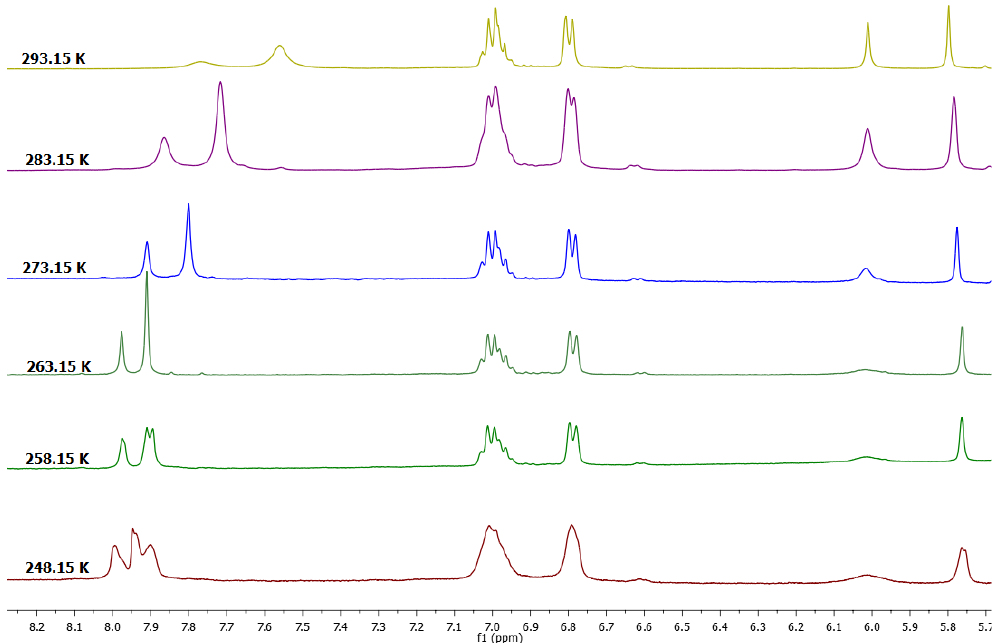
Figure 4. Dynamic study of tetra(phenyl)-pyrogallol[4]arene ( 2a ) in MeCN-DMSO-d 6 mixture. According to the known experimental evidence for aliphatic resorcinarenes and pyrogallolarenes, those exhibit a rigid cone( rccc ) structure at room temperature in solution and solid state [42,43] which is established due to the intramolecular hydrogen bonds in the upper rim. In